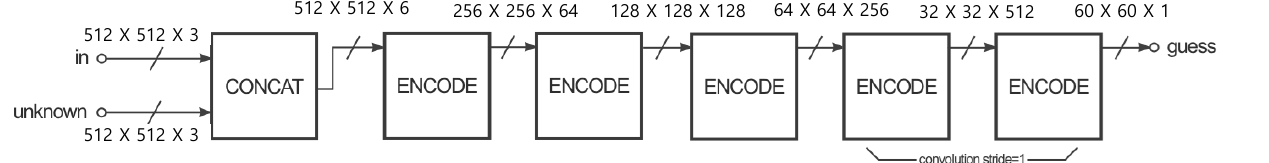
Figure 10. Conditional GAN training for line drawing extraction from 2D cartoon images. 4. Experimental Results and Analysis 4.1. Experimental Environments Table 1 shows the experimental environment and design for evaluating the proposed method. The datasets used for the learning consisted of cartoon images (Figure 11a) and their corresponding line drawings (Figure 11b) created from 896 three-dimensional mod- els. The image size was 512 × 512 pixels. The line drawing used in the study consisted of a subdivision surface twice larger than that of the 3D model. The feature lines consisted of a combination of contours, suggestive contours, ridges, valleys, apparent ridges and boundaries. We also performed experiments with a dataset without a subdivision surface to determine the effect of the subdivision surface. We used 10-fold cross-validation for the evaluation. The test was performed by increasing the training time by 100 units from the 200th to the 400th. Figure 11. Example of training data: ( a ) cartoon image and ( b ) line drawing.